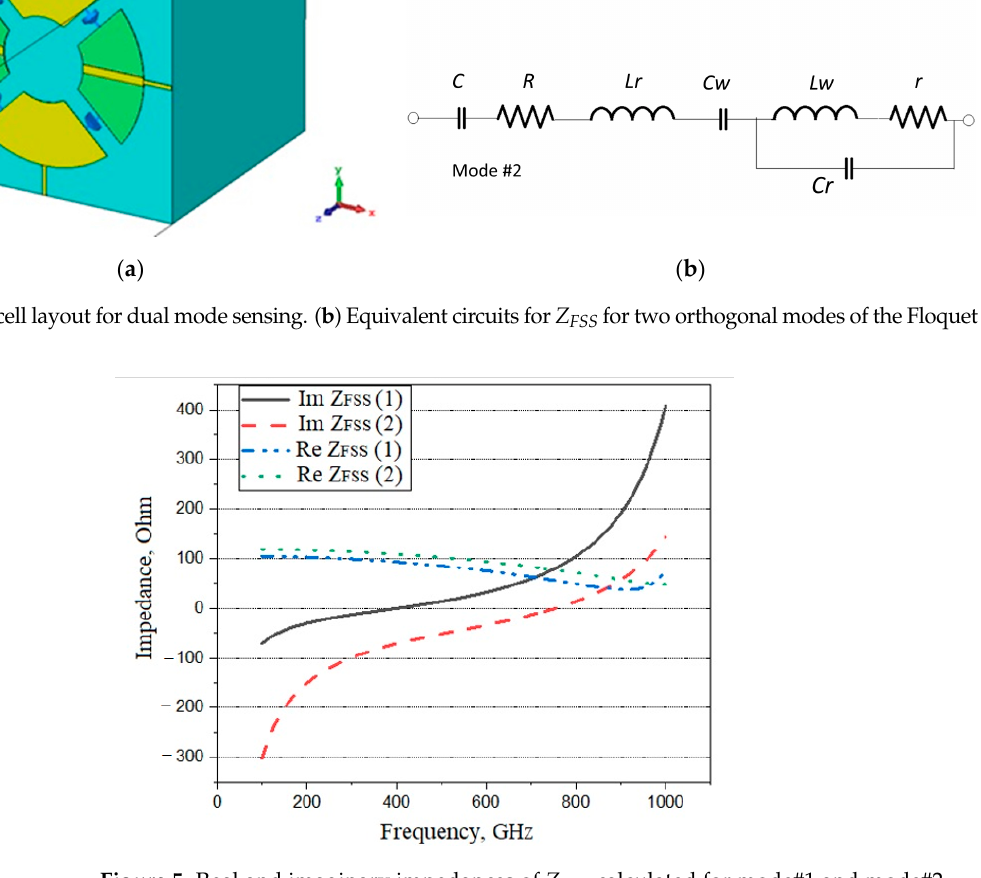
Figure 5. Real and imaginary impedances of Z FSS calculated for mode#1 and mode#2.